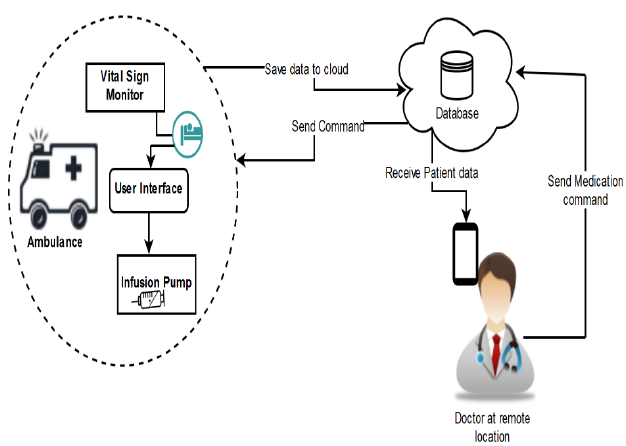
Figure 2 . Working model of hybrid drug delivery system